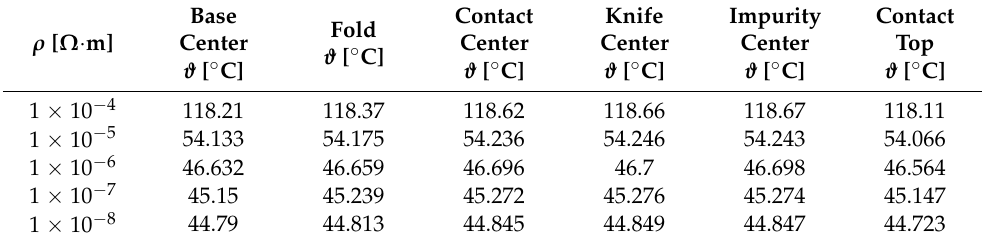
Table 5. Temperature measurements of the high ‐ current copper contact.